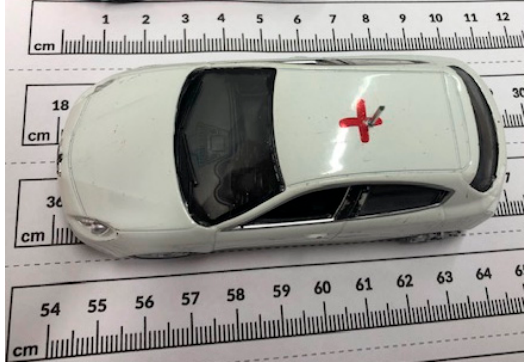
Figure 3. A metallic car with an antenna for differential imaging.